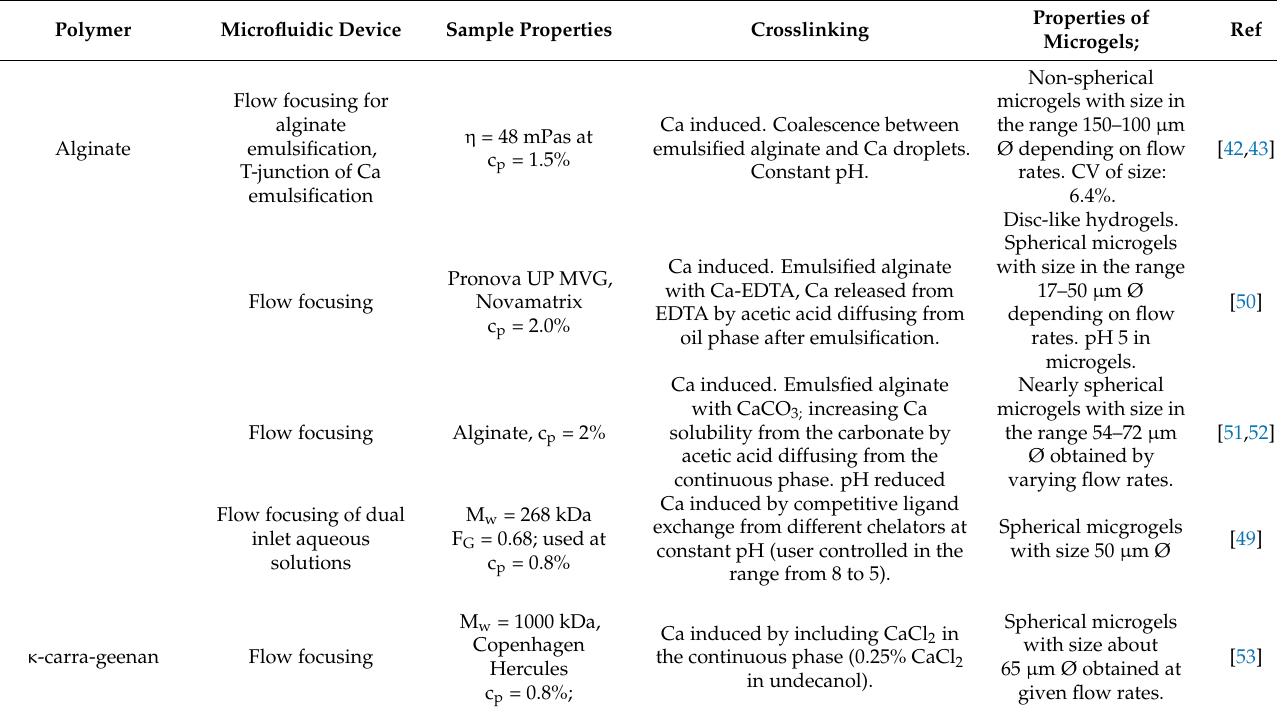
Table 2. Examples of microfluidic-assisted microgel fabrication processes